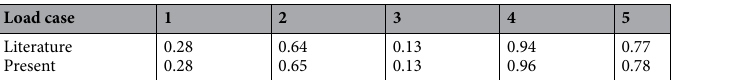
Table 4. Comparison of the maximum bending moment between the present results and those in the literature.